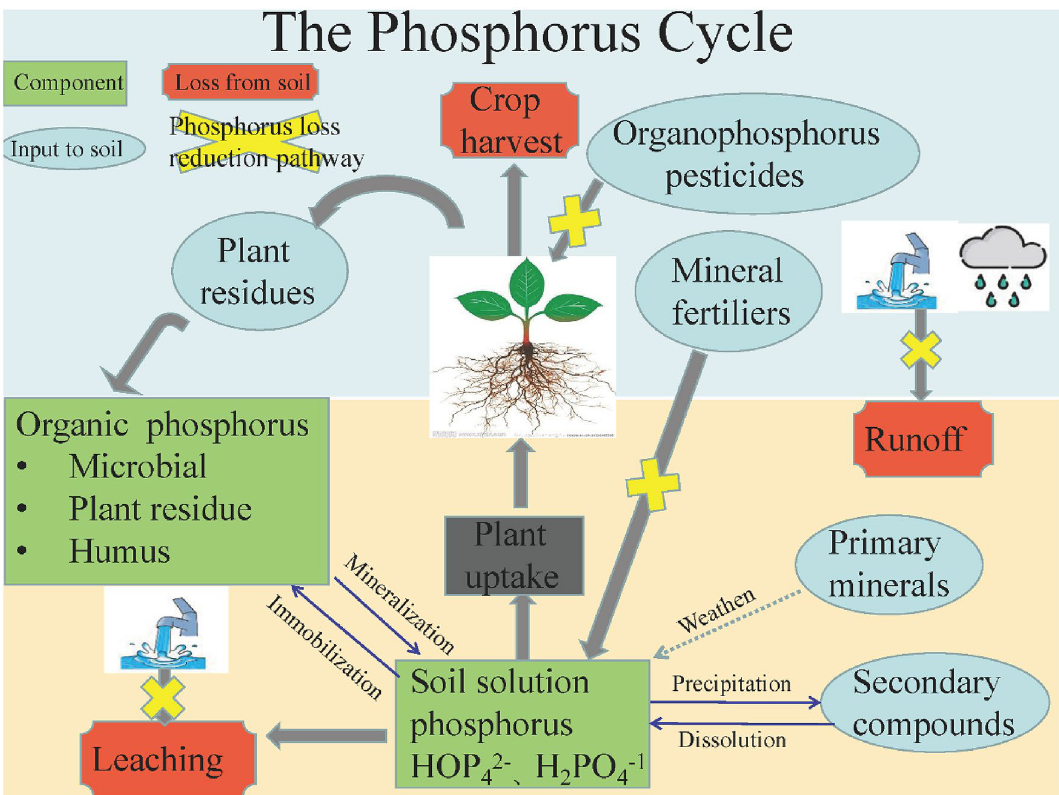
Figure 4. The concept of soil phosphorus cycle from planting and the priority control path for the reduction TP